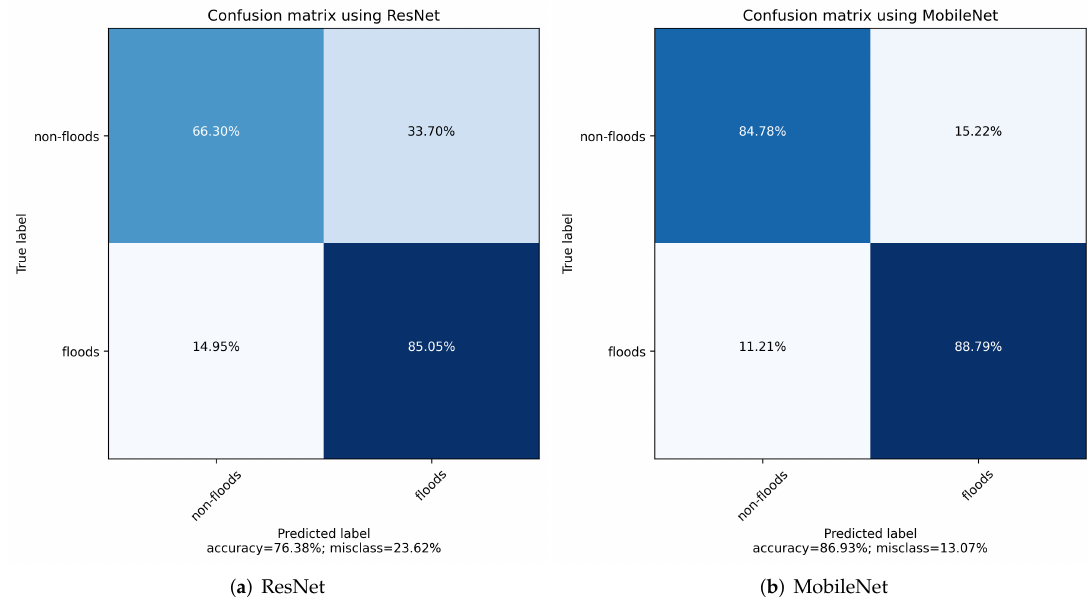
Figure 5. The confusion matrix for flood damage classification using ( a ) ResNet and ( b ) MobileNet. The locations of four possible predictions are: TN (top left), FP (top right), FN (lower left), and TP (lower